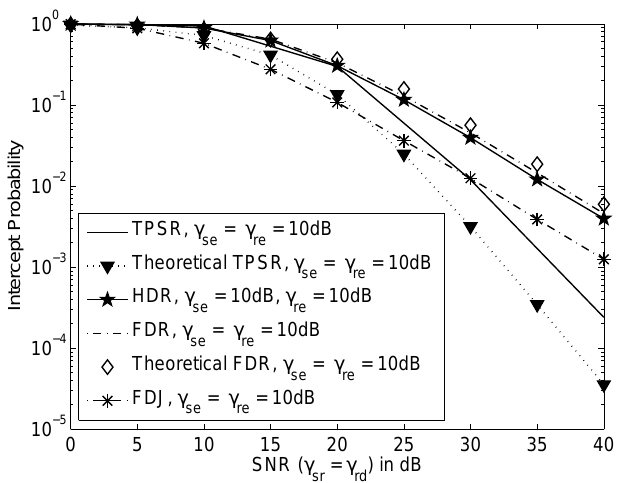
Figure 3. Intercept probability versus SNR where γ sr = γ rd , γ se = γ re = 10dB and the inter-relay interference or self-interference, γ rr =